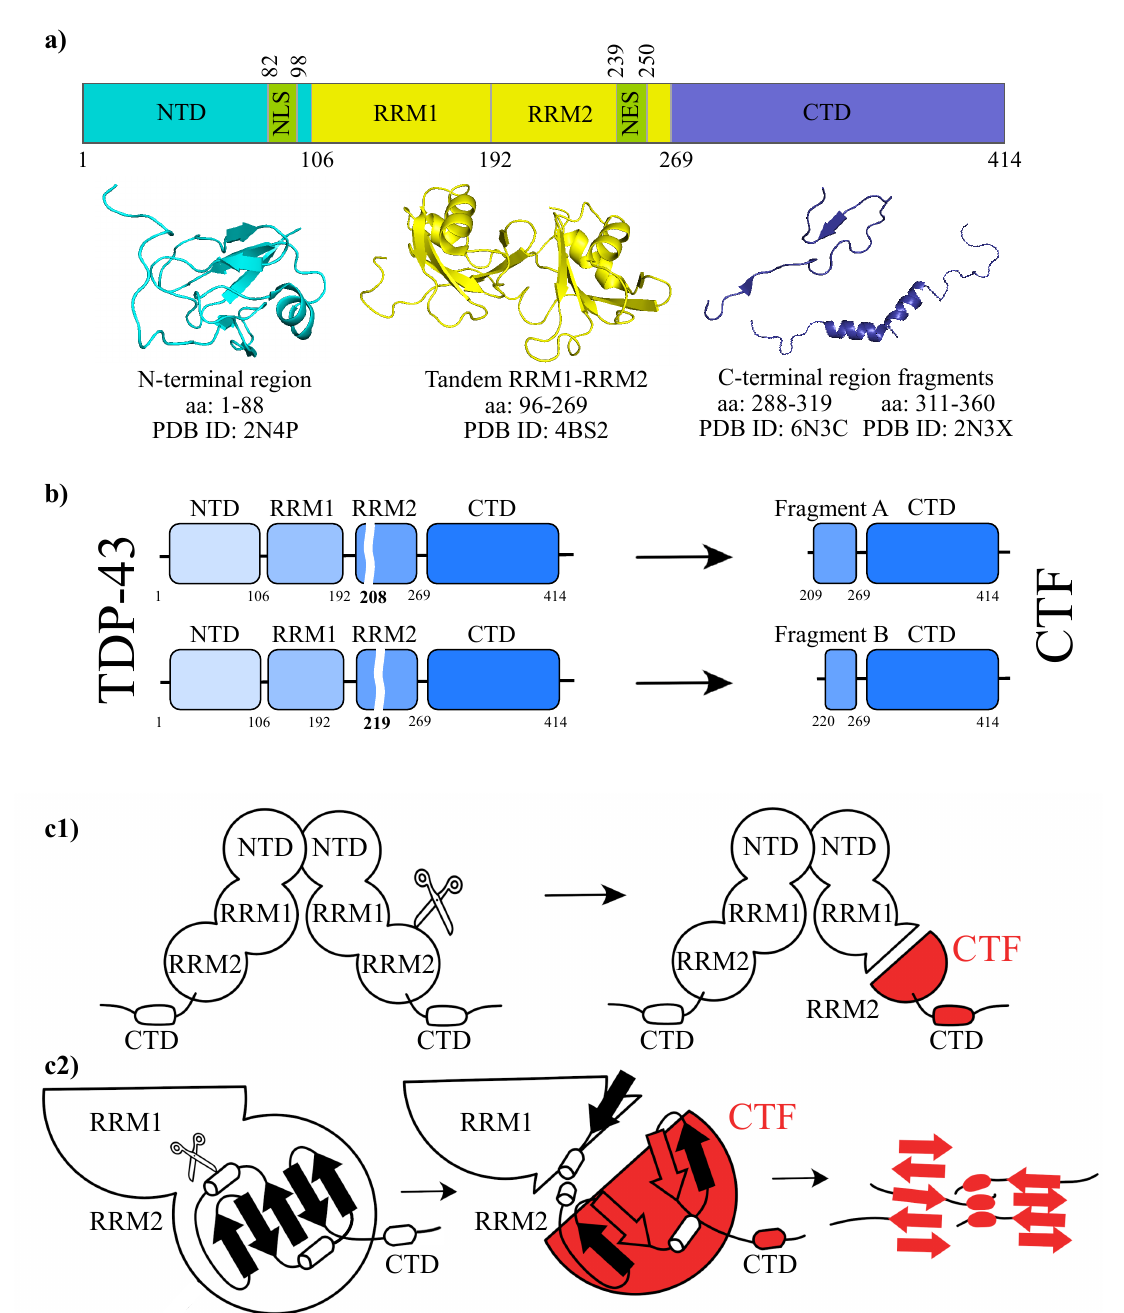
Figure 1. Structural organization of TDP-43 and hypothesized model for CTFs aggregation. ( a ) TDP-43 comprises an NTD, two RRM domains, a nuclear export signal (NES), a nuclear localization signal (NLS), and a disordered C-terminal domain. The cartoon representation of the structure of the NTD portion comprising residues 1–88 (PDB ID: 2N4P) is shown in blue, the structure of residues 96–269 of the tandem RRM1-RRM2 domains (PDB ID: 4BS2) in yellow. Two fragments of the CTD are reported in violet, counting residues 288–319 (PDB ID: 6N3C) and 311–360 (PDB ID: 2N3X). ( b ) Schematic representation of the two possible cleavages of TDP-43 (at sites 208 or 219) from which the CTFs can be originated. The two truncated RRM2 fragments are called Fragment A and B, respectively. ( c1 ) After the cleavage, the CTF is split from the whole TDP-43, which, in physiological conditions, forms dimers. ( c2 ) Scheme of the hypothesized aggregation model. The RRM2 fragment resulting from the cleavage exposes its β -strands; the β -strands from different CTFs allow the formation of aggregates to